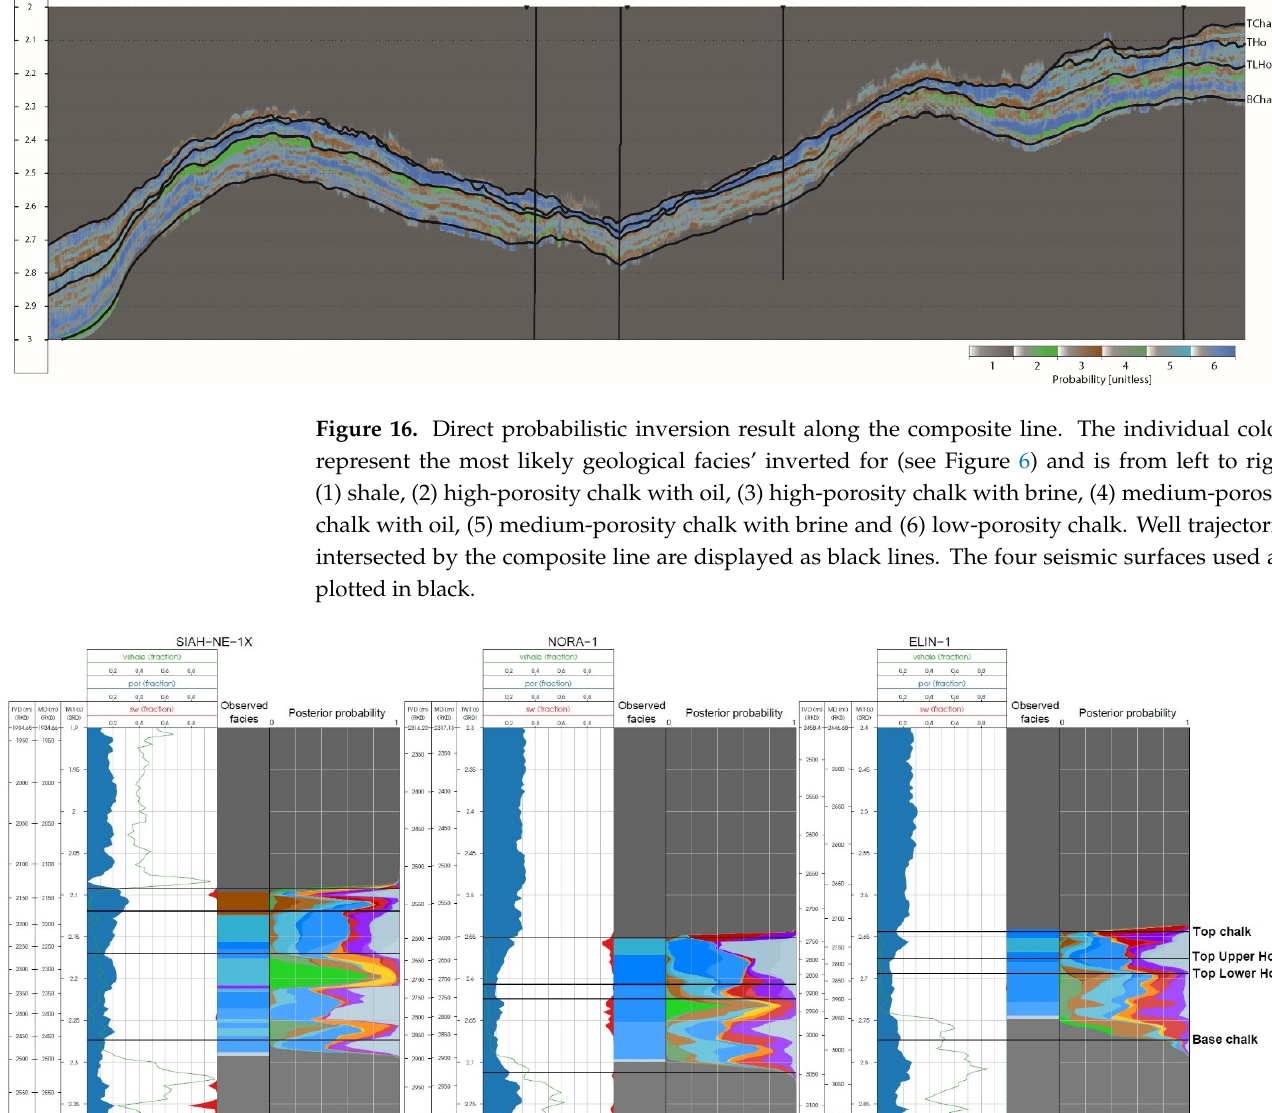
Figure 16. Direct probabilistic inversion result along the composite line. The individual colors rep- resent the most likely geological facies’ inverted for (see Figure 6) and is from left to right: (1) shale, (2) high-porosity chalk with oil, (3) high-porosity chalk with brine, (4) medium-porosity chalk with oil, (5) medium-porosity chalk with brine and (6) low-porosity chalk. Well trajectories intersected by the composite line are displayed as black lines. The four seismic surfaces used are plotted in black.